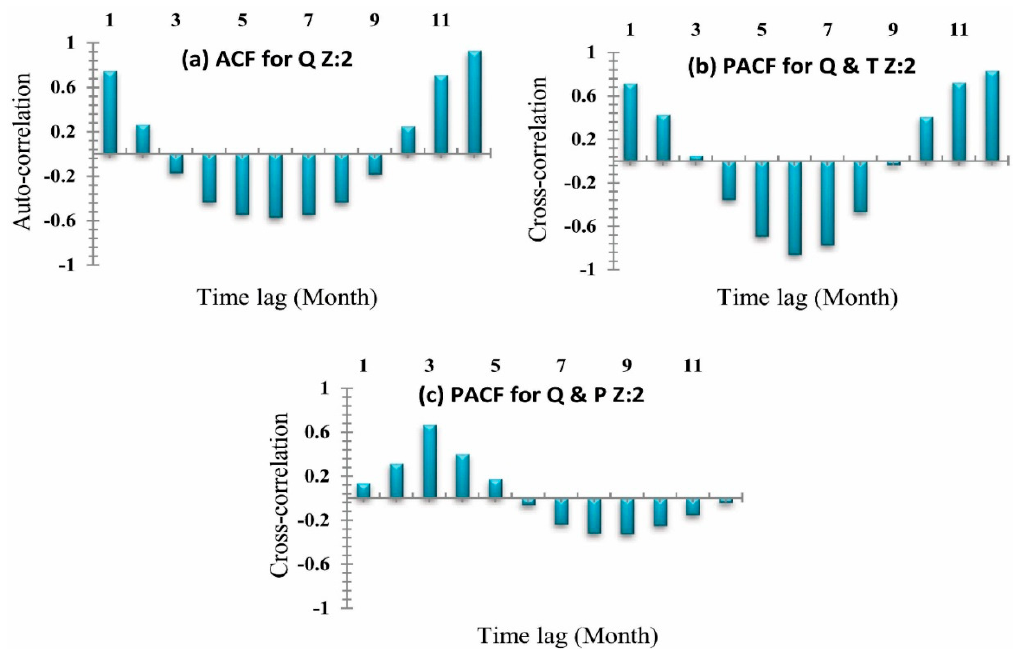
Figure 11. Zone Two ( a ) Auto-correlation coefficients for stream-flow. ( b ) Cross-correlation coefficient for stream-flow and temperature. ( c ) Cross-correlation coefficient for stream-flow and rainfall.